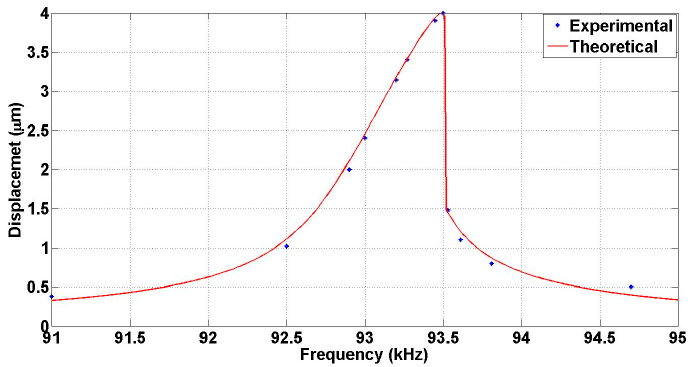
Figure 16. Displacement vs. frequency at 150 V DC &10 V AC for design B Mirror travel range.